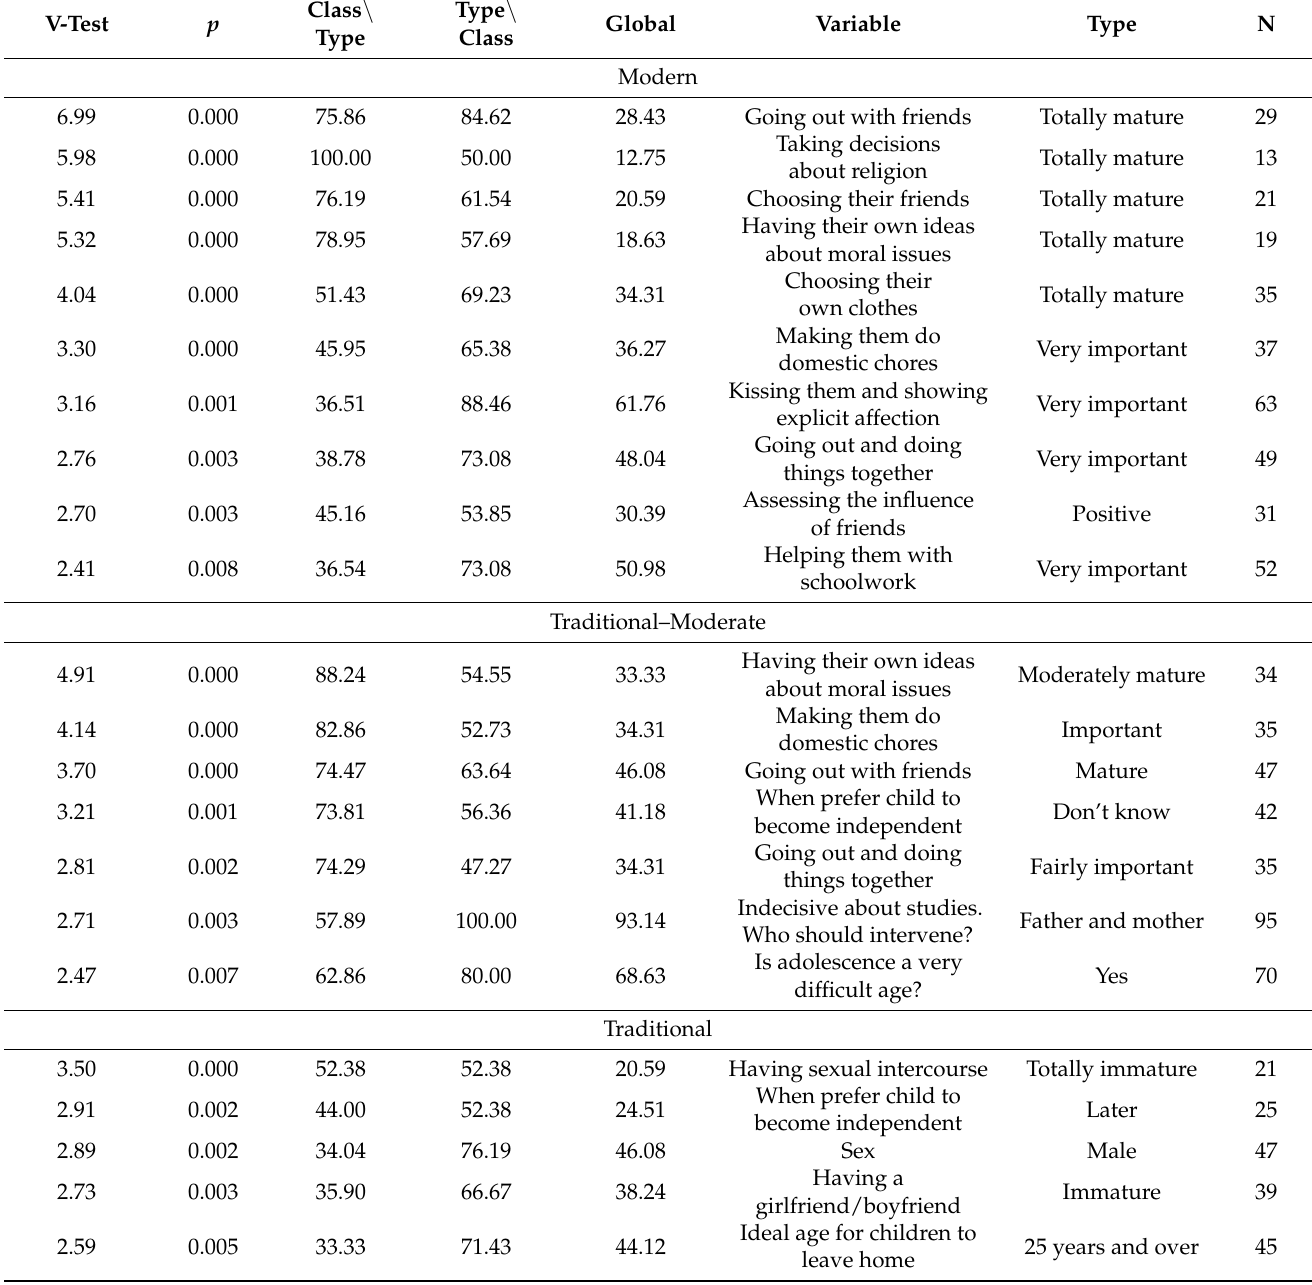
Table 4. Response types for the different classes regarding ideas about adolescence (Type/Class >